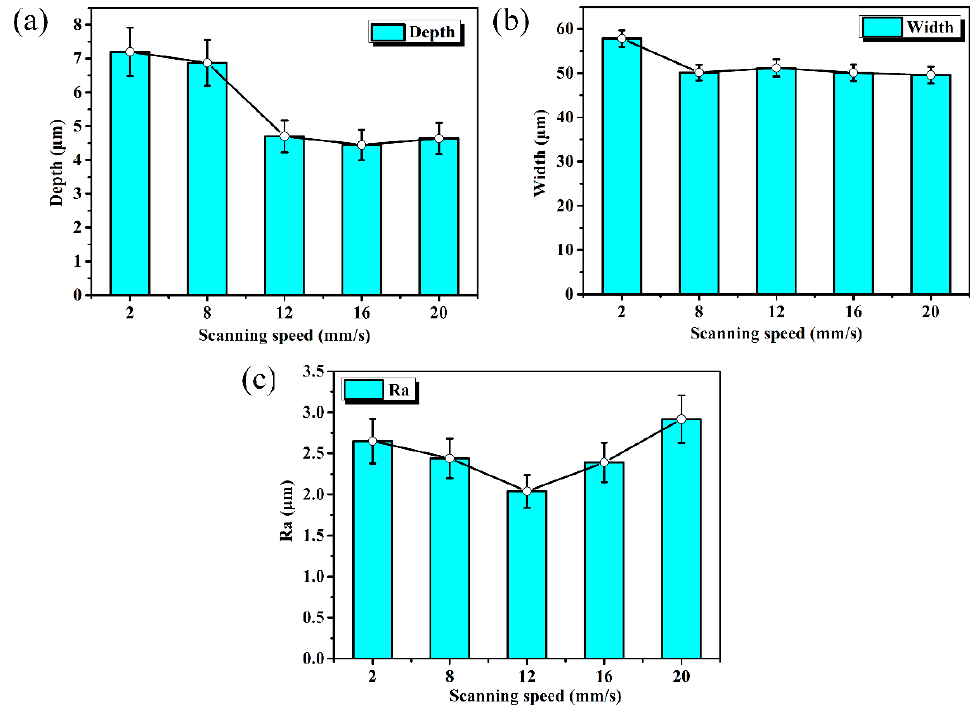
Figure 7. The width, depth, and Ra of microdimple structures under different scanning speeds. ( a ) The influence of scanning speed on dimple depth. ( b ) The influence of scanning speed on dimple width. ( c ) The influence of scanning speed on surface roughness.